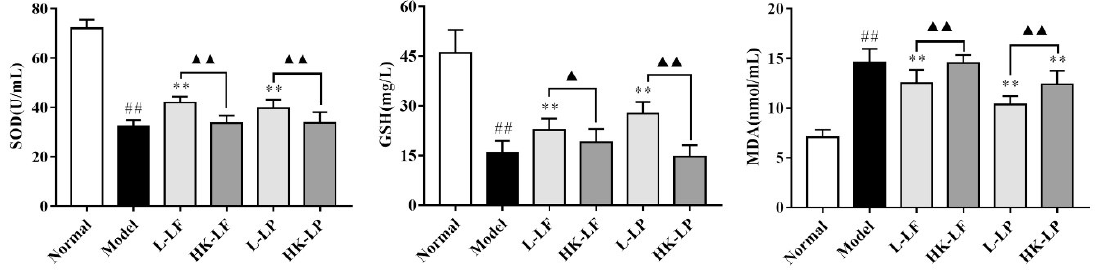
Figure 6. The levels of antioxidant indexes in serum. ## p < 0.01 compared with the normal group, ** p < 0.01 compared with the model group, ▲ p < 0.05 and ▲▲ p < 0.01.